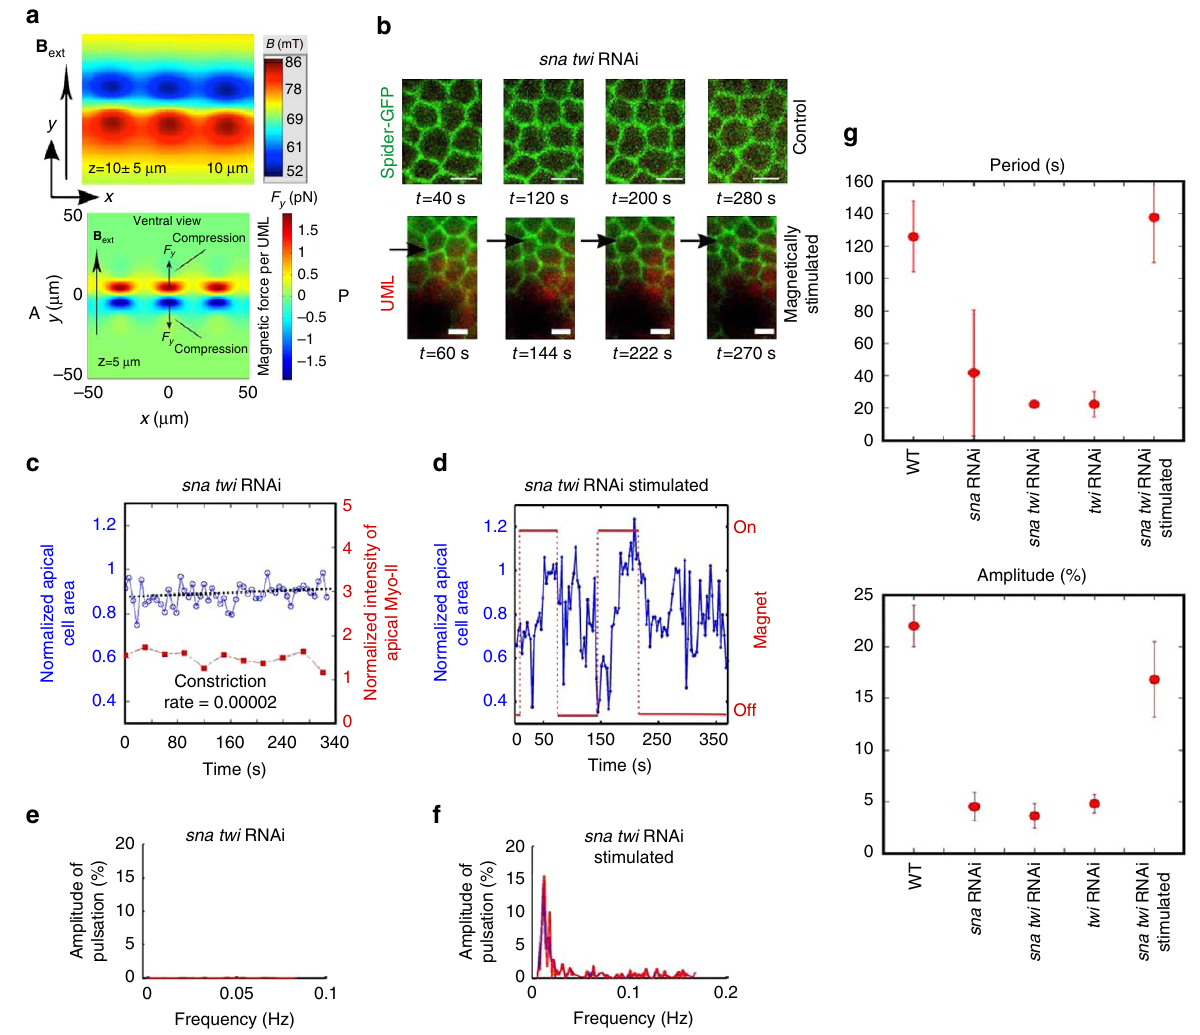
Figure 2 | Mimicking of sna -dependent apex pulsations in mesoderm cells. ( a ) Up: ventral view of the magnetic field measured on the apical surface of mesoderm cells. Quantitative estimate of the stray field produced in the vicinity of the micro-magnets, measured by scanning hall probe microscopy (probe tilted by 23 (cid:2) ) at a distance of 10 ± 5 m m above the micro-magnets. Bottom: ventral view of the magnetic force F y on the apex of the mesoderm cells. Simulation of the in-plane ( y component) magnetic force experienced by an UML positioned in the plane 5 m m above the micro-magnets. ( b ) Magnetic stimulation of apex pulsations by the application of a pulsed magnetic field to micro-magnets (shadowy object at bottom of images) positioned close to UML-loaded mesoderm cells on sna twi spider–GFP embryos. Green corresponds to Gilgamesh and red to UML. ( c ) Variation of the apical surface (in blue) and Myo-II concentration (in red) as a function of time in the sna twi RNAi. Representative of the n ¼ 11 quantified cells of the N ¼ 745 cells observed in six distinct embryos. ( d ) Variation of the apical surface area (in blue) of cell pulsations induced by the application of a pulsed magnetic field to micro-magnets positioned close to UML-loaded mesoderm cells, in sna twi RNAi. Representative of the n ¼ 12 quantified cells of the 71 pulsating cells on the N ¼ 726 cells observed in six distinct embryos. ( e ) Spectral signature of apex surface area fluctuations in the mesoderm cells of sna twi RNAi embryos. Representative of the n ¼ 3 quantified cells of the N ¼ 745 cells observed in six distinct embryos. ( f ) Spectral signature of magnetically induced apex surface pulsations in the mesoderm cells of sna twi RNAi embryos. Representative of the n ¼ 12 quantified cells of the 55 pulsating cells on the N ¼ 596 cells observed in five distinct embryos. ( g ) Period and amplitude of mesoderm cell apex pulsations in the WT, versus sna RNAi ( P per ¼ 0.006, P amp ¼ 0.002), sna twi RNAi ( P per ¼ 0.01, P amp ¼ 0.01) , twi RNAi ( P per ¼ 0.007, P amp ¼ 0.002), consistently repressing the pulsating effects of its sna target gene in the presumable case twi RNAi is efficient enough, and sna twi RNAi magnetically stimulated ( P per ¼ 0.4, P amp ¼ 0.005), and sna twi RNAi versus sna twi RNAi magnetically stimulated embryos ( P per ¼ 0.013, P amp ¼ 0.011). P values are calculated from the Mann–Whitney test, and error bars are